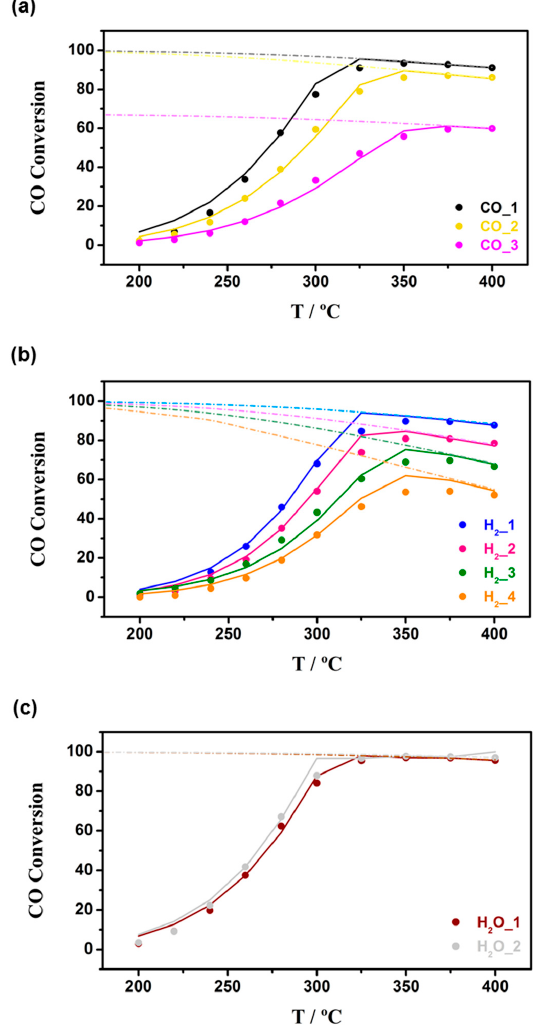
Figure 4. CO Conversion vs Temperature plots of the tested experiments. The experimental data is plotted as dots. Calculated data (Equation (15)) is plotted as solid lines. The equilibrium curves are plotted by dashed lines. ( a ) Effect of inlet CO concentration; ( b ) effect of inlet H 2 concentration; and ( c ) effect of inlet H 2 O concentration.